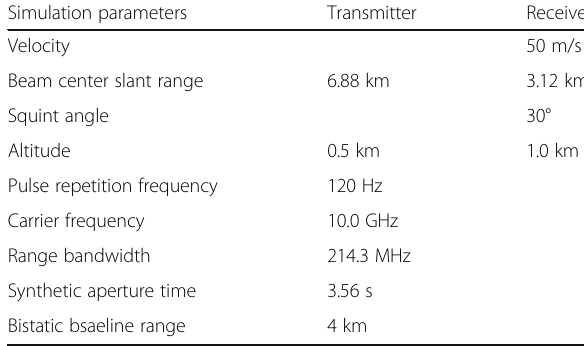
Table 3 Stationary parameters of BiSAR for case II Simulation parameters